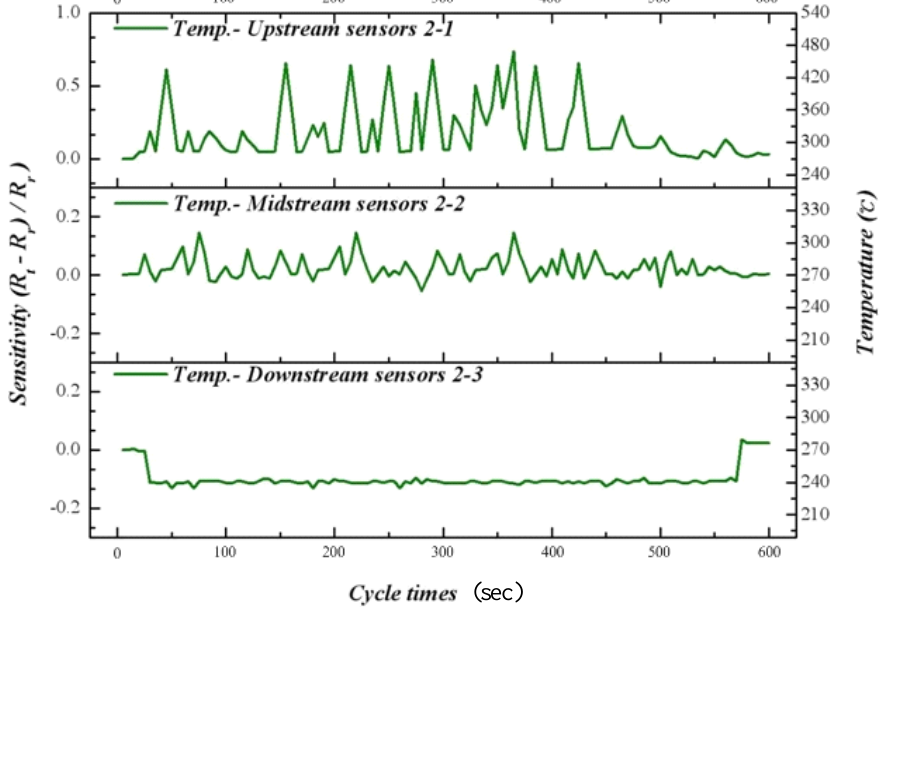
Figure 9. Inner temperature distribution of micro reformer at area 2-1, 2-2, 2-3 (OSRM; 270 